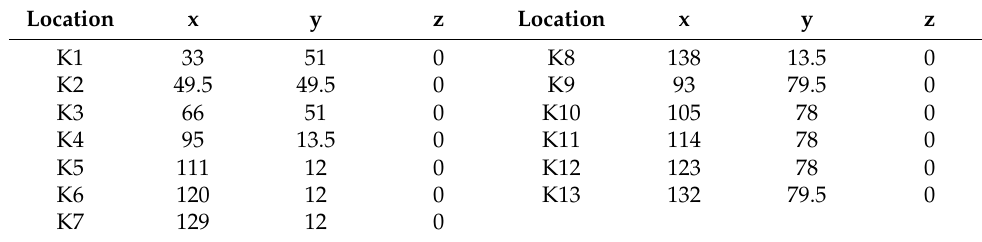
Table 5. Coordinates of the candidate location of the tower